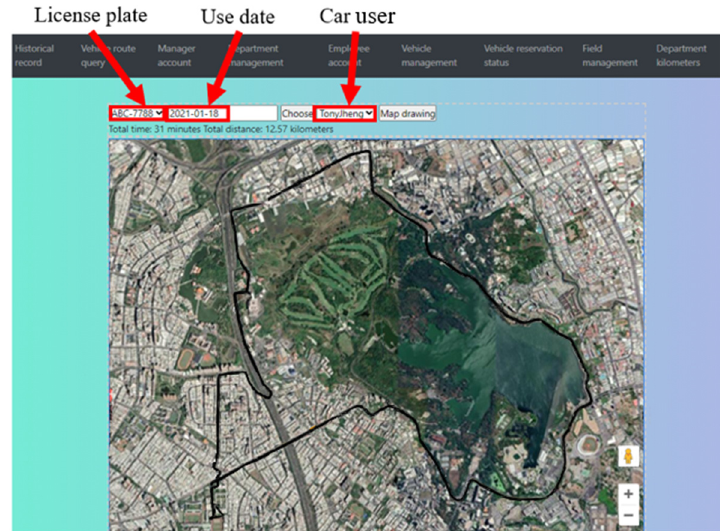
Figure 36. Back-end vehicle path query.